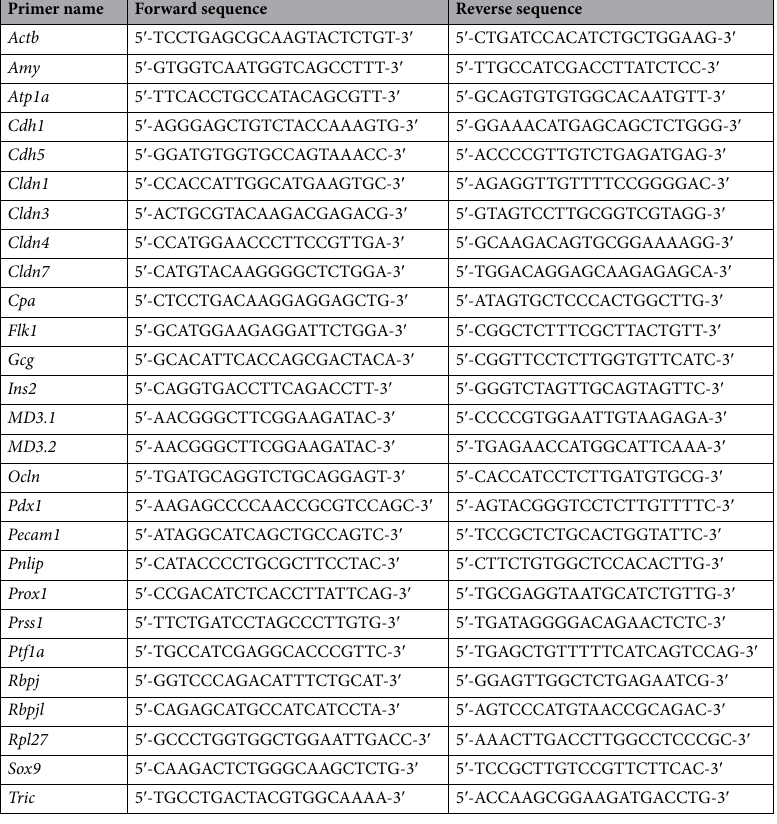
protease treatment were then performed. Probes for MarvelD3 and Ubc (positive control) were hybridized on adjacent sections, for 2 h at 40 °C in the HybEZ II oven. Signal amplification was obtained with 6 amplification steps according to the manufacturer’s protocol (duration of treatment and temperature). mRNAs were revealed using alkaline phosphatase Fast Red chromogenic staining. Sections were counterstained with Mayer’s haema- toxylin solution, and scanned using the Pannoramic P250 Slide Scanner. Three embryos from the same litter were analysed. RT‑qPCR and statistical analysis. Tissues collected from embryos until day E15.5 were collected and immediately snap-frozen in liquid nitrogen. Total RNA was extracted using TRIzol Reagent (Thermo Scientific) followed by phenol/chloroform extraction, as described 27 . E17.5 pancreata and 2 × 2 mm pieces of adult pan- creata were submerged into RNAlater Stabilization Solution (Thermo Scientific) and frozen in liquid nitrogen. Total RNA was extracted using the REliaPrep RNA Tissue Miniprep System (Z6111, Promega), according to the manufacturer’s instructions for small (≤ 5 mg) fibrous tissue samples. Reverse transcription was realized on 500 ng of total RNA with random hexamer primers and the M-MLV Reverse Transcriptase (Invitrogen). The Kapa SYBR Fast qPCR kit (Sopachem) was used for RT-qPCR on the obtained cDNAs. Primers sequences for the different genes are listed in Table 2. Data were analysed according to the Livak method (ΔΔCT) and were represented as mean ± standard deviation of mRNA Log 2 fold changes relative to the expression of housekeeping gene β-actin , or of Rpl27 (Fig. 1A). In dot plots, each symbol represents one mouse of a particular MarvelD3 genotype: green circles for wild-type, orange squares for heterozygous, and red triangles for knockout. Between 4 and 7 samples were analysed. Statistical analyses were realized using non-parametric tests: Mann–Whitney for comparison of 2 conditions, Kruskall-Wallis for more conditions. In case of a significant (i.e. p < 0.05) Kruskall- Wallis test, Mann–Whitney tests were realized between control and tested conditions to acknowledge a potential significant difference, which is represented by * when p < 0.05 and ** when p < 0.01. Western blotting. Pancreas and kidney tissue samples were homogenized in classical RIPA Buffer (Fig. 3D) or Urea Lysis Buffer (Urea 6 M, NaCl 100 mM, Tris 50 mM pH8, 1% Triton X-100, 0,1% SDS) (Fig. 5A et S3A) using an Ultra-Turrax T10 (Ika). Total protein concentration was assessed via a bicinchoninic acid assay. 50 μg of proteins were diluted 3 × into urea Sample Buffer (Urea 6 M, Tris–HCl 0.188 M pH6.8, DTT 150 mM, 6% SDS, 30% glycerol, 0.003% bromophenol blue), and deposited onto a 8% SDS polyacrylamide gel (3% stacking gel).